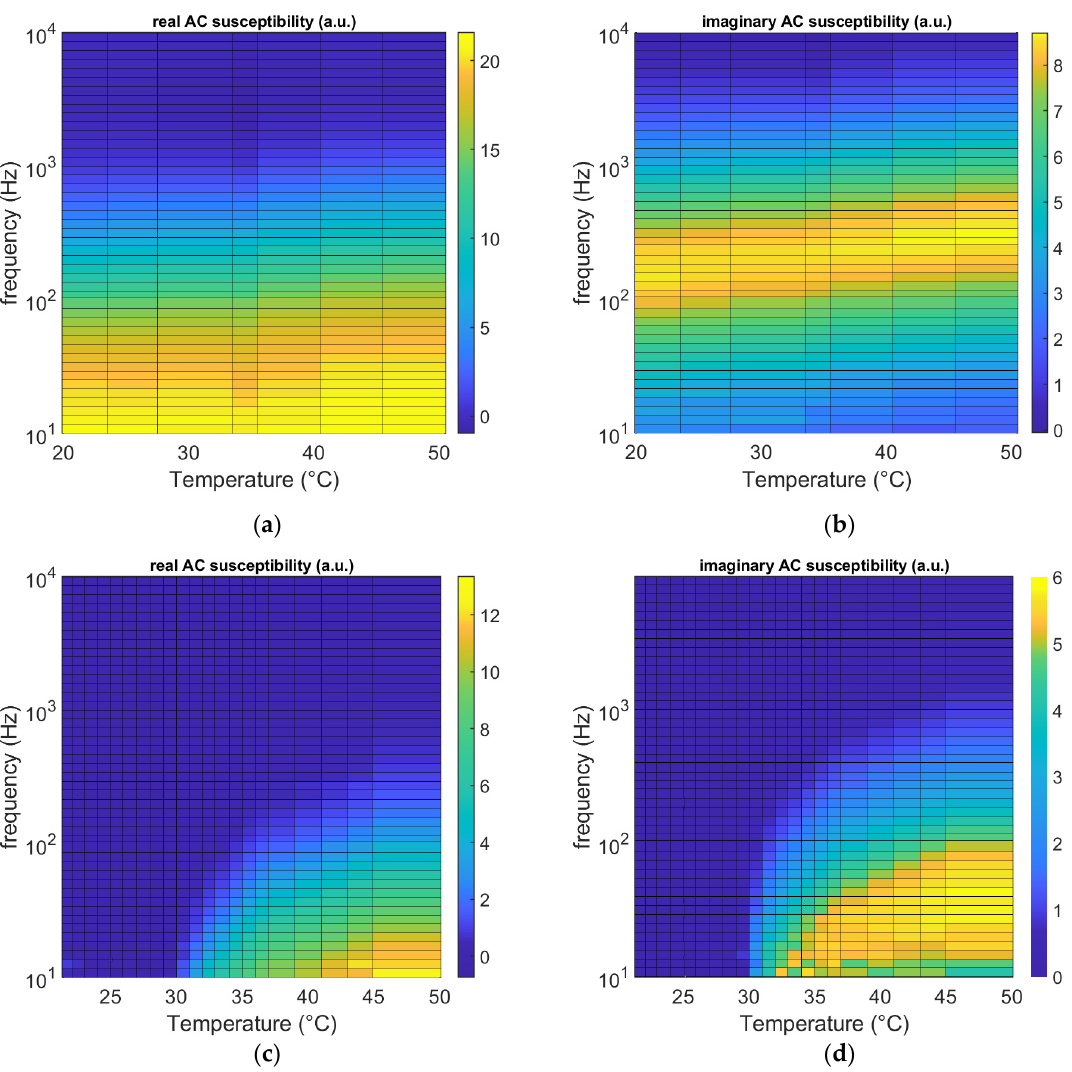
Figure 4. The real and imaginary components of AC susceptibility are plotted as a function of temperature and frequency for ( a , b ) MNPs suspended in DI water and ( c , d ) MNPs in the gelatin matrix. The color code represents the amplitude of the real and imaginary AC susceptibility signals.